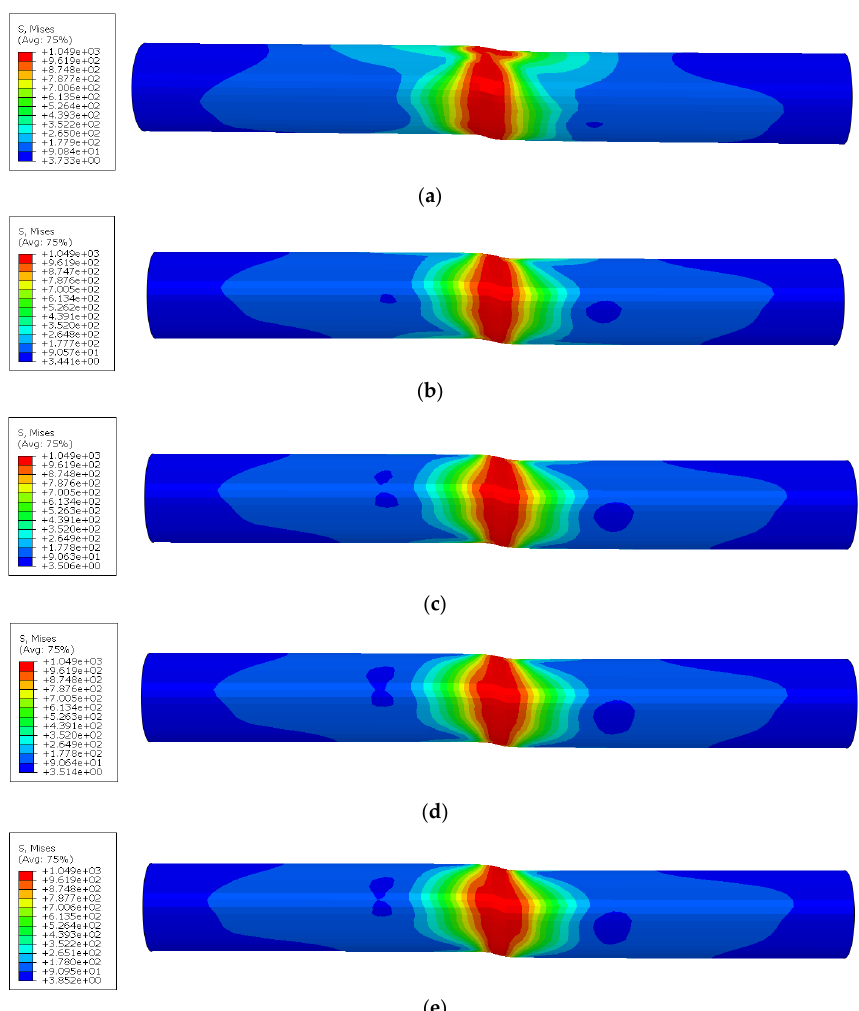
Figure 23. Cloud map of finite element calculation results. ( a ) Rock compressive strength 100 MPa, ( b ) rock compressive strength 150 MPa, ( c ) rock compressive strength 200 MPa, ( d ) rock compressive strength 250 MPa, ( e ) rock compressive strength 300 MPa.